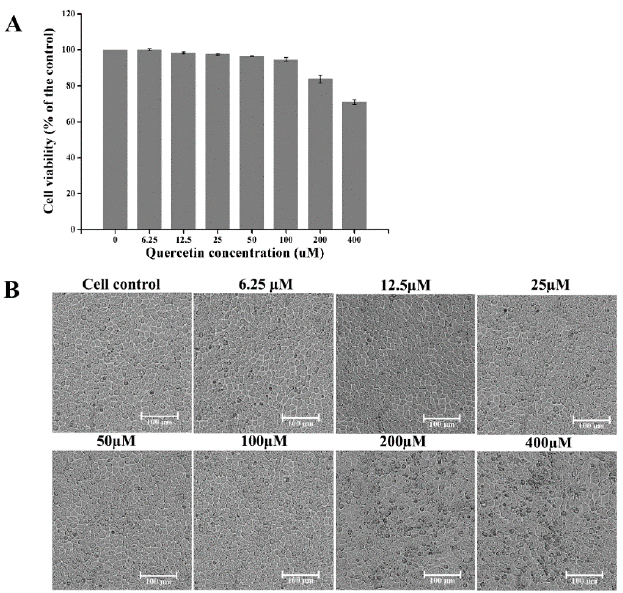
Figure 1. The cytotoxicity of quercetin on CCL-81 cells. ( A ) CCL-81 cell viability was measured by Cell Counting Kit-8 (CCK-8). All of the values were normalized to the cell control, which represents 100% cell viability. ( B ) CCL-81 cell morphology in the presence of quercetin at different concentrations. Data are shown as the means ± standard deviation (SD) of three independent experiments, with the error bars representing the standard deviations.